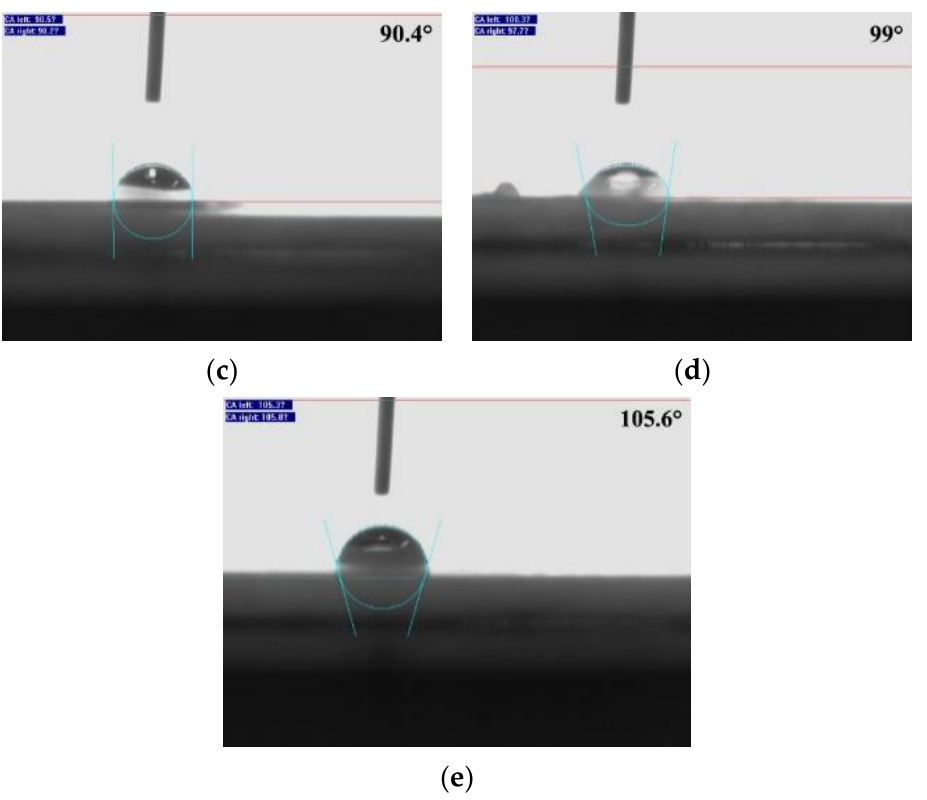
Figure 5. Contact angles of PBA-g-PDMAEMA sample at pH = 13: ( a ) 1:1, ( b ) 5:1, ( c ) 15:1, ( d ) 20:1, and ( e ) 25:1.